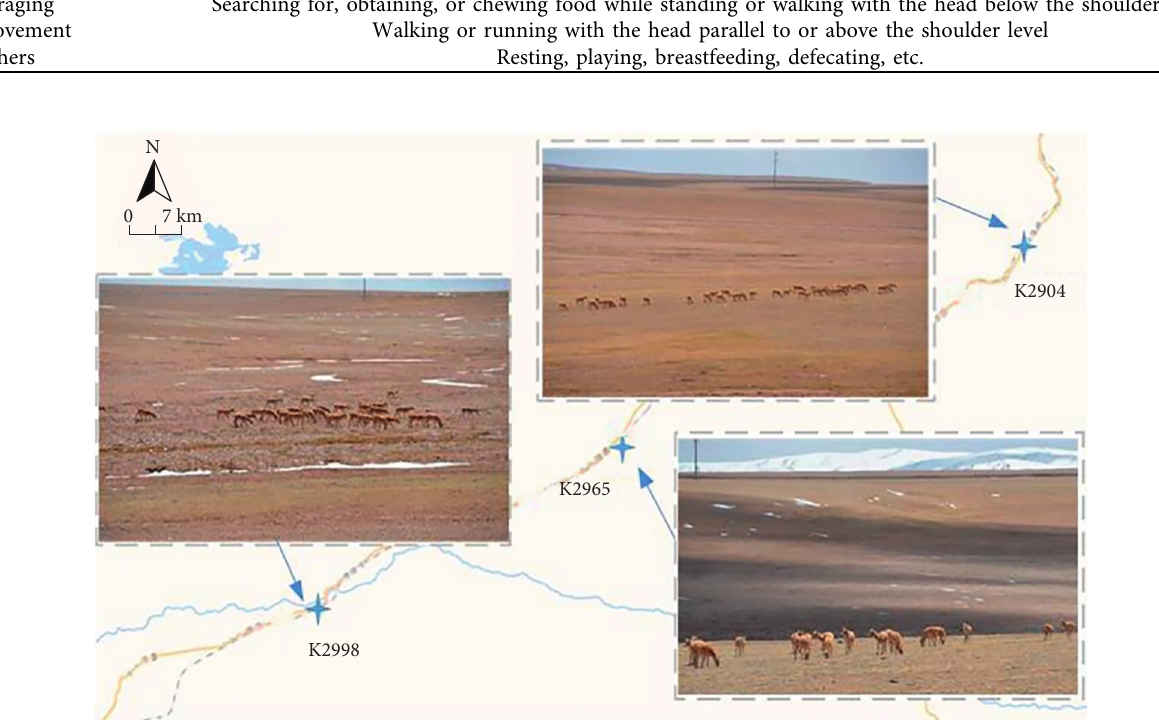
Figure 2: Tibetan antelope population on the roadside.